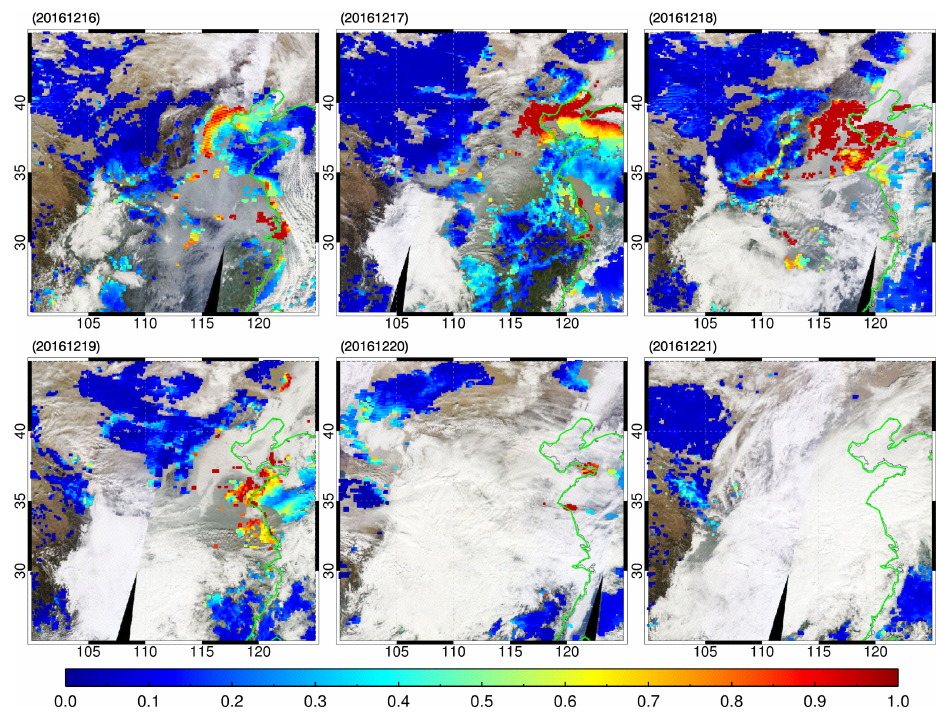
Figure 6. Daily MODIS RGB and AOT for East China (100–125 ◦ E, 25–45 ◦ N) during the period 16–21 December 2016 (from top left to bottom